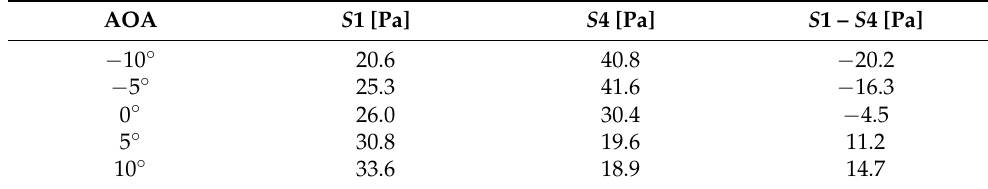
Table 3. Pressure differential readings at 6 m/s and an angle of attack between − 10 ◦ and 10 ◦ .